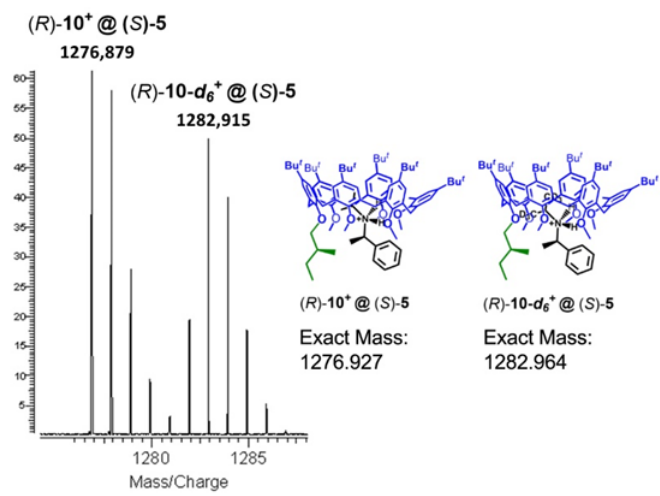
Figure 9. Significant portion of the mass spectrum of a 1:2:2 mixture (CH 2 Cl 2 , 300 μM) of derivatives ( S )- 5 , ( R )- 10 + ∙[B(Ar F ) 4 ] − , and ( R )- 10 - d 6 + ∙[B(Ar F ) 4 ] − ,